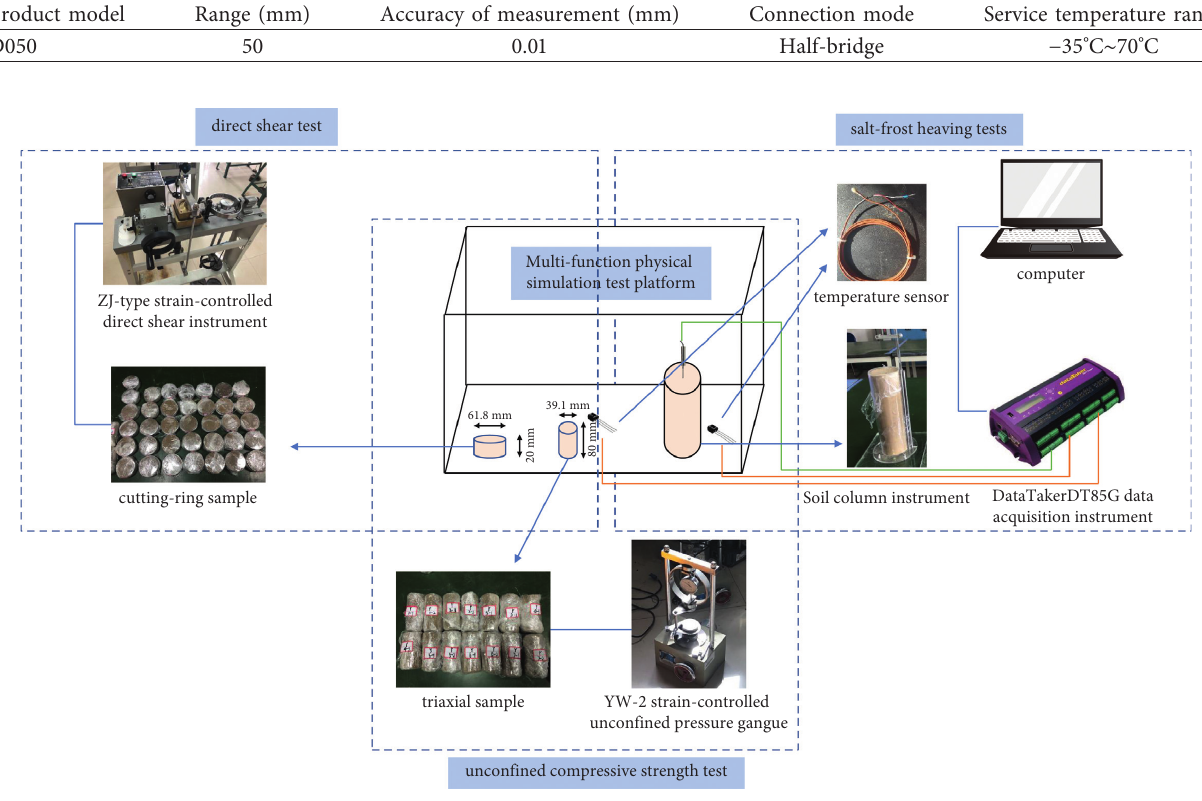
Figure 6: Test device